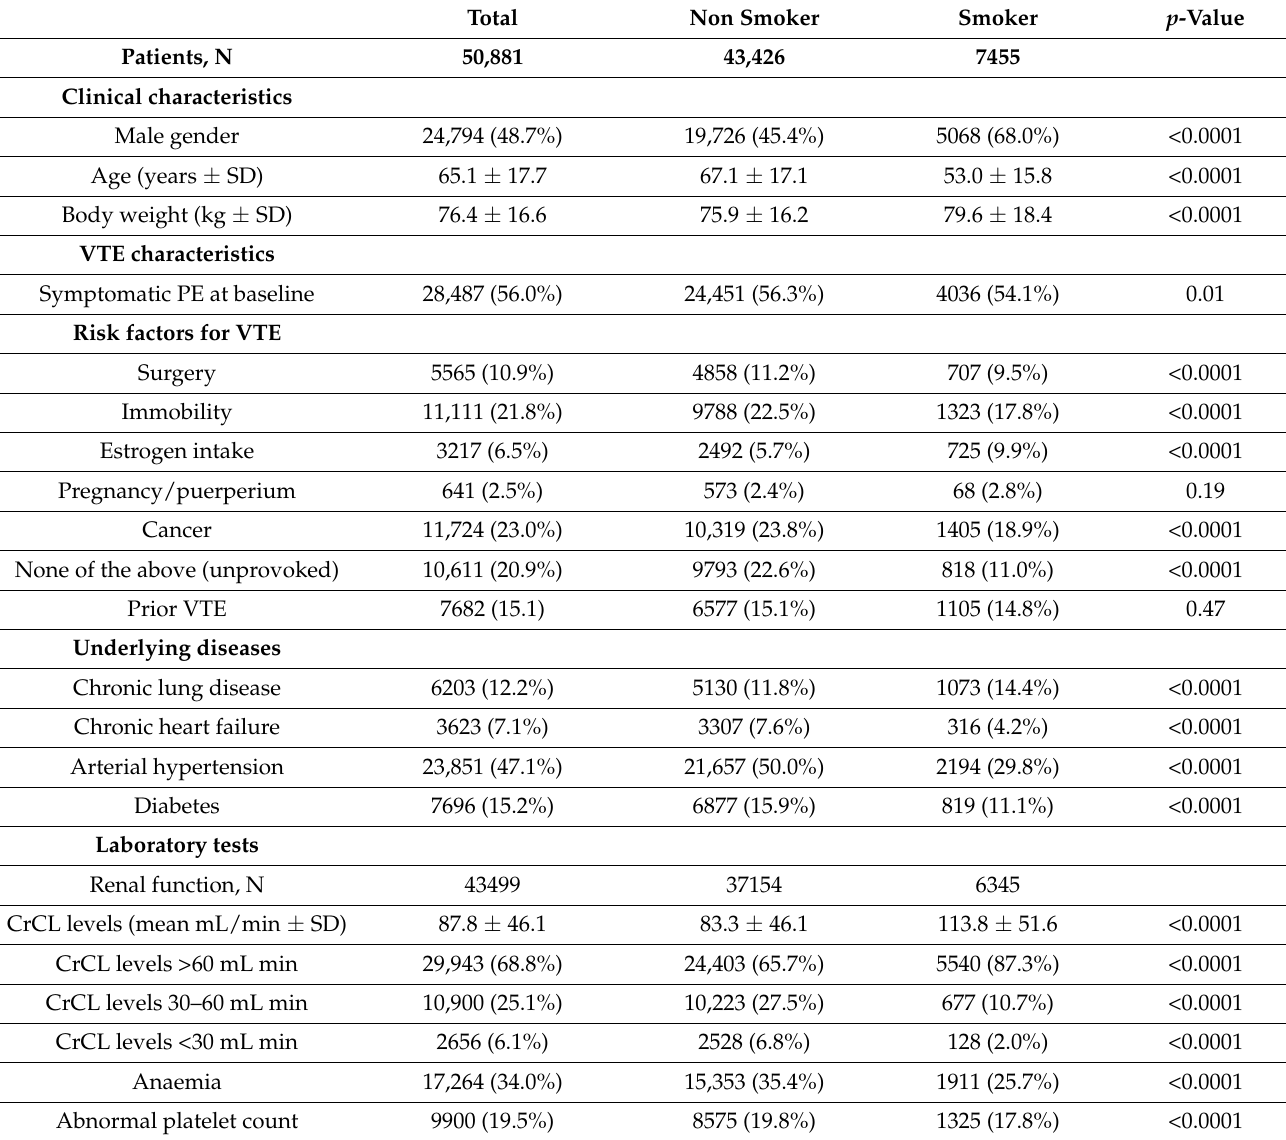
Table 1. Clinical characteristics of the patients according to smoking behavior at baseline. Total Non Smoker Smoker p -Value Patients, N 50,881